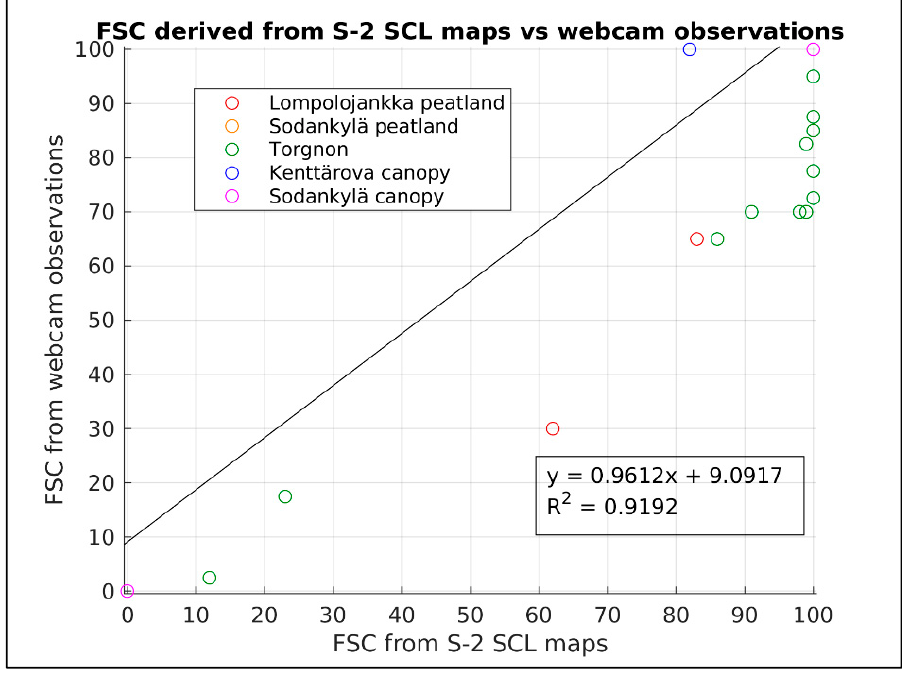
Figure 12. Distribution of compared value pairs.